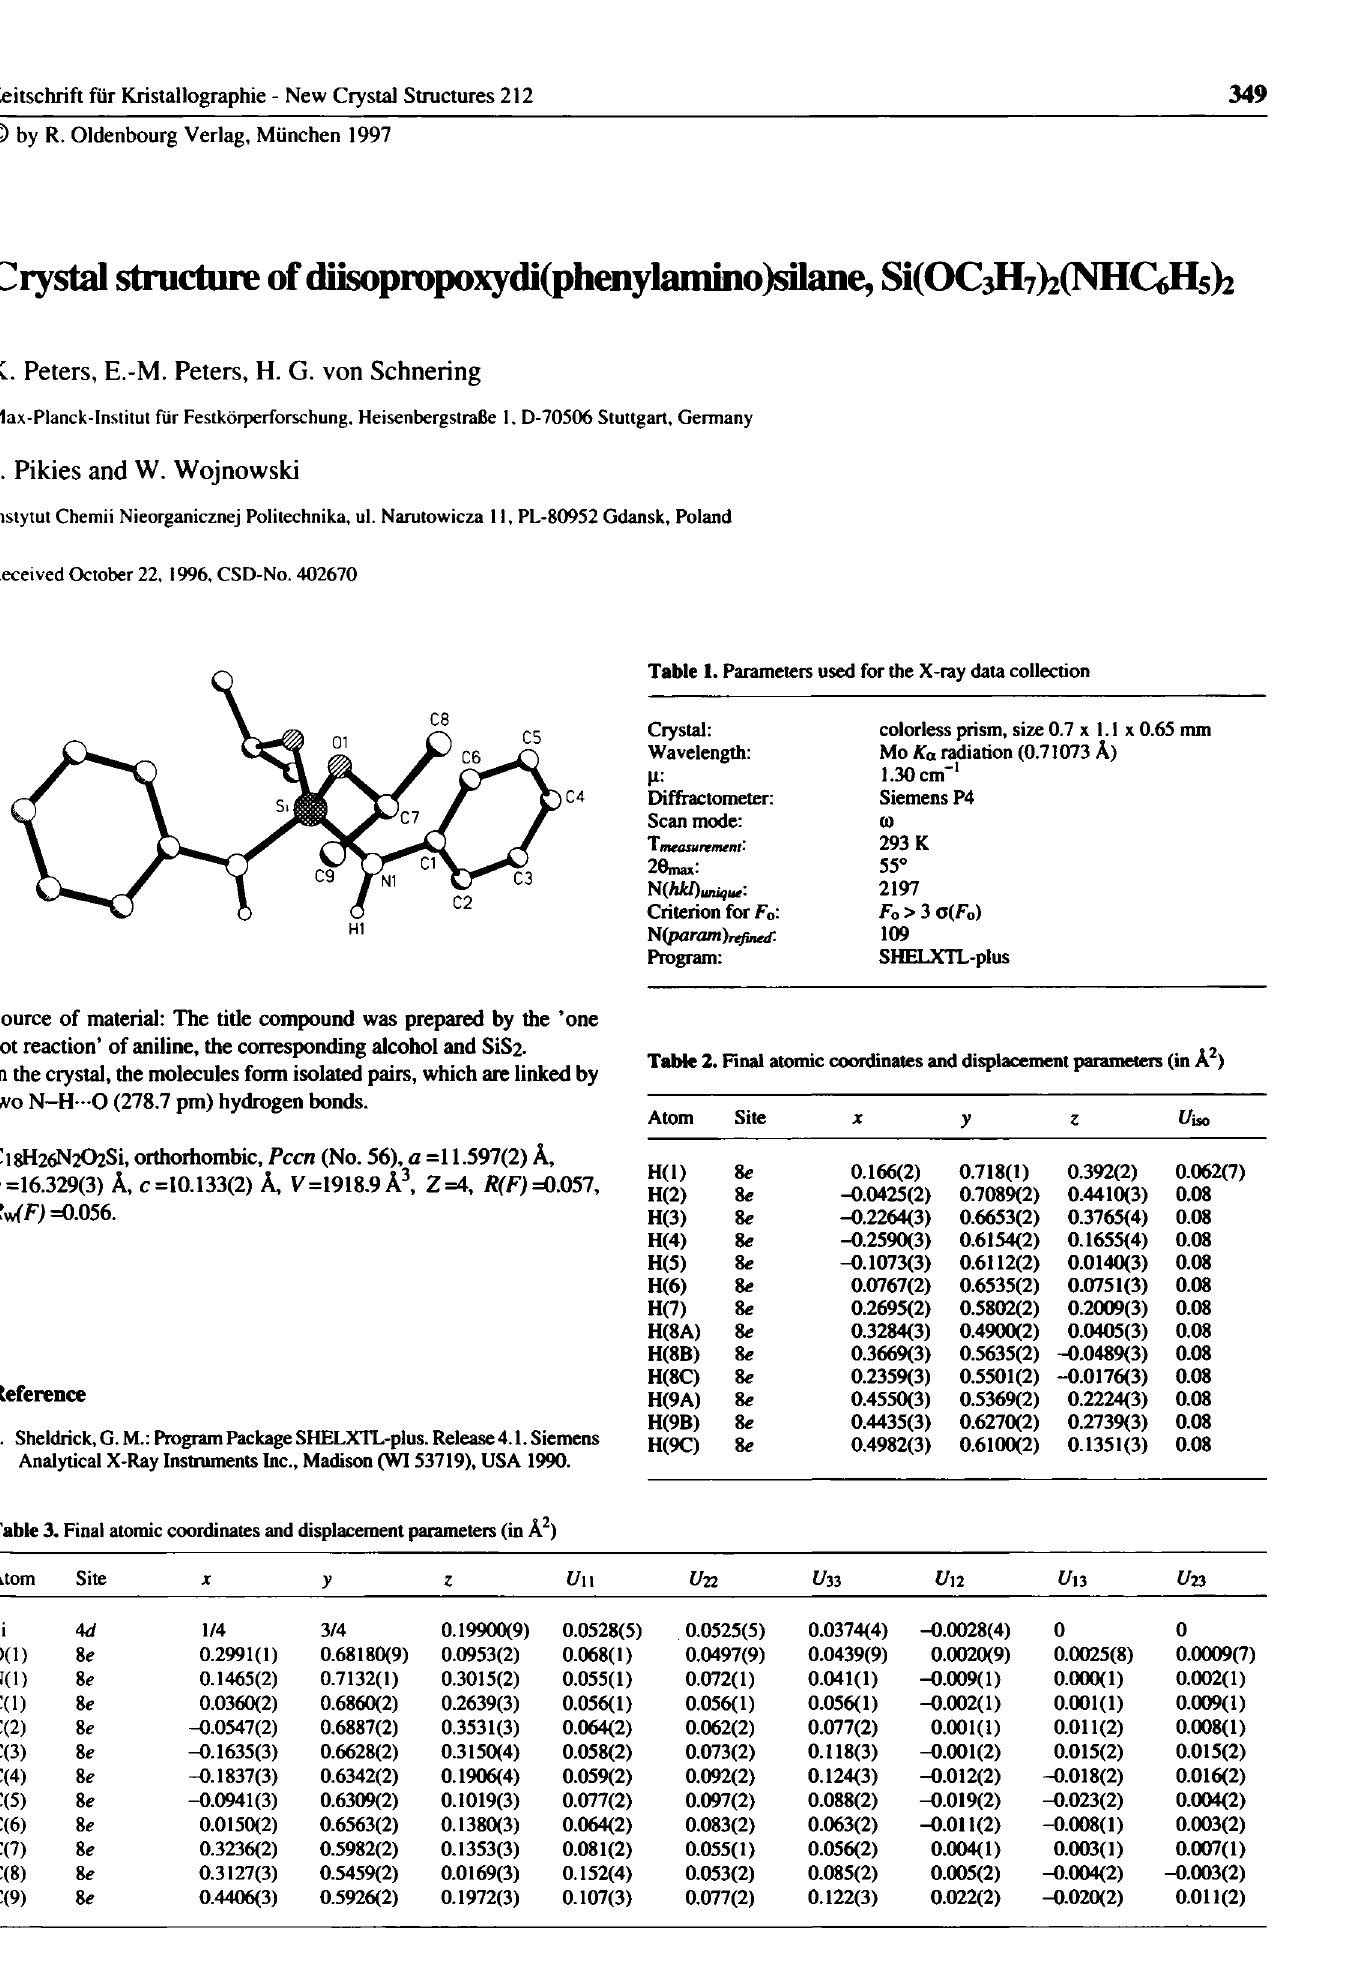
Table 1. Parameters used for the X-ray data collection Crystal: Wavelength: μ: Diffractometer: